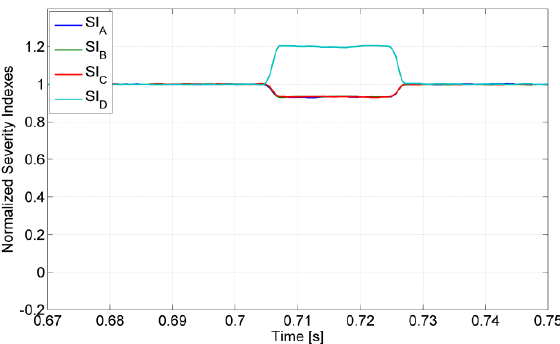
Figure 16. Results of the four normalized indexes for a short-circuit fault in the semiconductor S 24 .